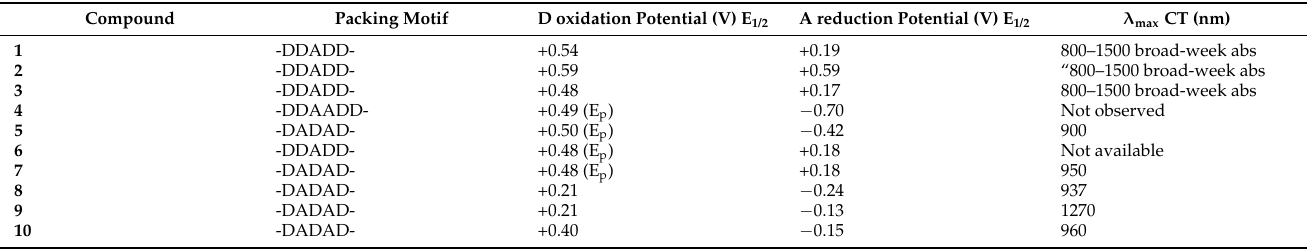
Table 1. Summary of packing motifs, donors and acceptor redox potentials and CT transition positions for the investigated